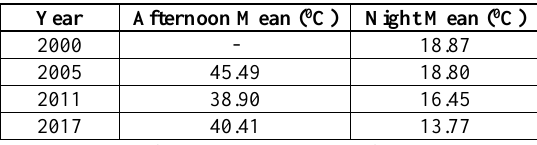
Table 5: Mean afternoon and night LST from 2000 to 2017 Mean afternoon and night time temperatures were compared with each land cover for the years 2005, 2011, 2015 and 2017 (Figure 7). Results showed that water had the highest LST in all years, both afternoon and night. Its high thermal capacity allows it to absorb and store heat from incoming solar radiation, slowly emitting it in form of long wave radiation. This creates a warming effect in the surrounding environments. This is contrary to LST of water taken in the morning at 10:00 am where it had the lowest mean LST (Figure 6).